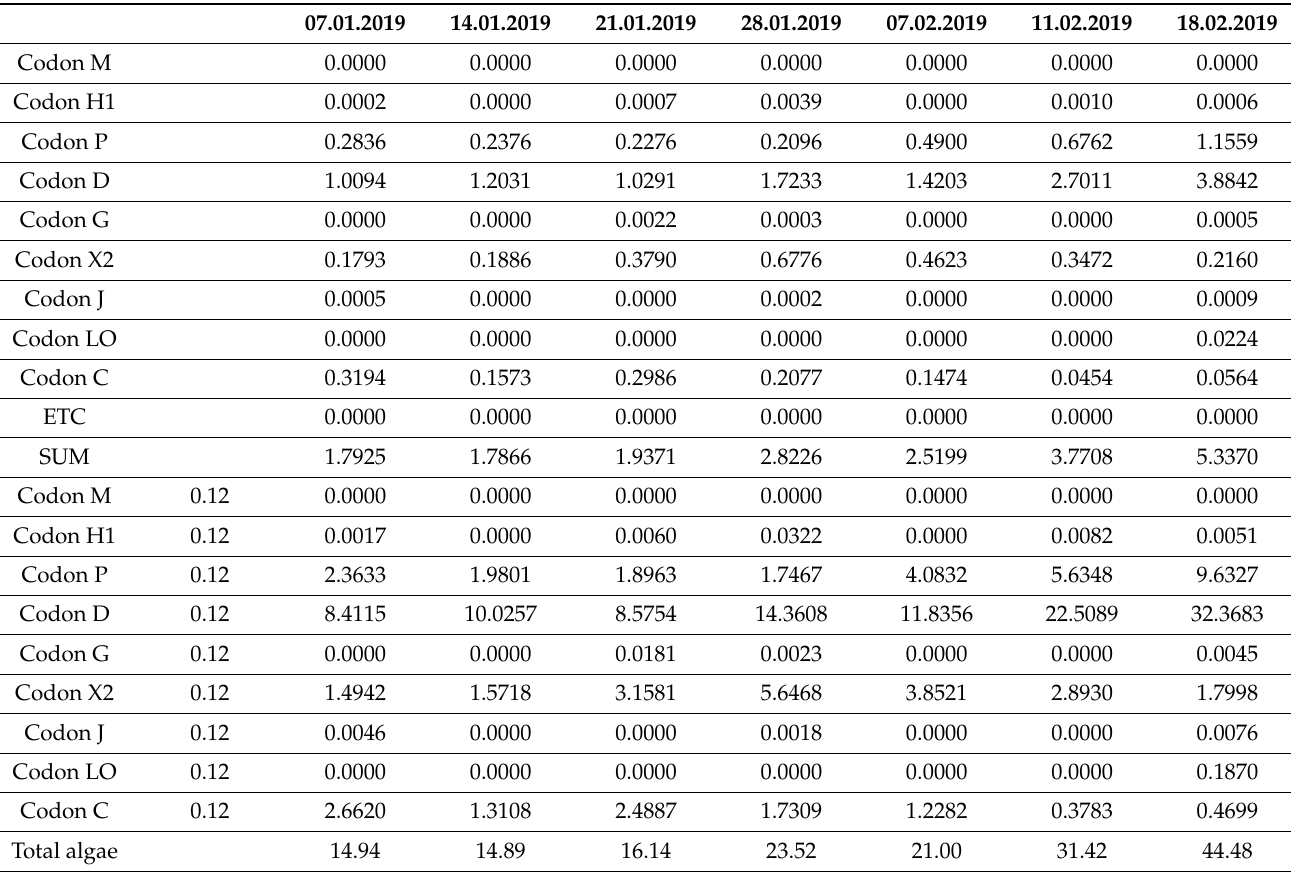
Table A2. Examples of calculating the carbon amount for each algal group and converting it to